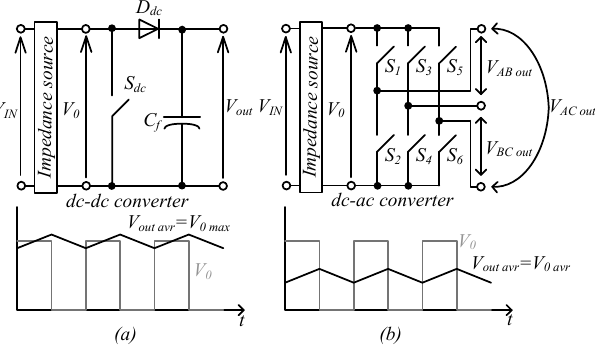
Figure 2. Di ff erence between the output voltage of ( a ) the impedance source dc-dc converter and ( b ) Figure 2. Difference between the output voltage of ( a ) the impedance source dc ‐ dc converter and ( b ) the dc-ac the dc ‐ ac converter.